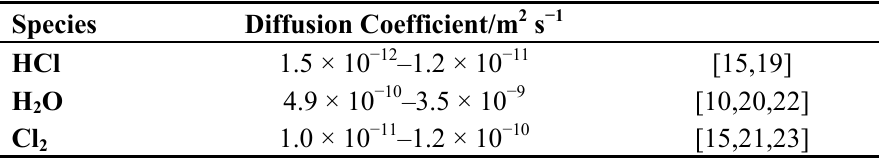
Table 1. Transport parameters of species involved in chlorine